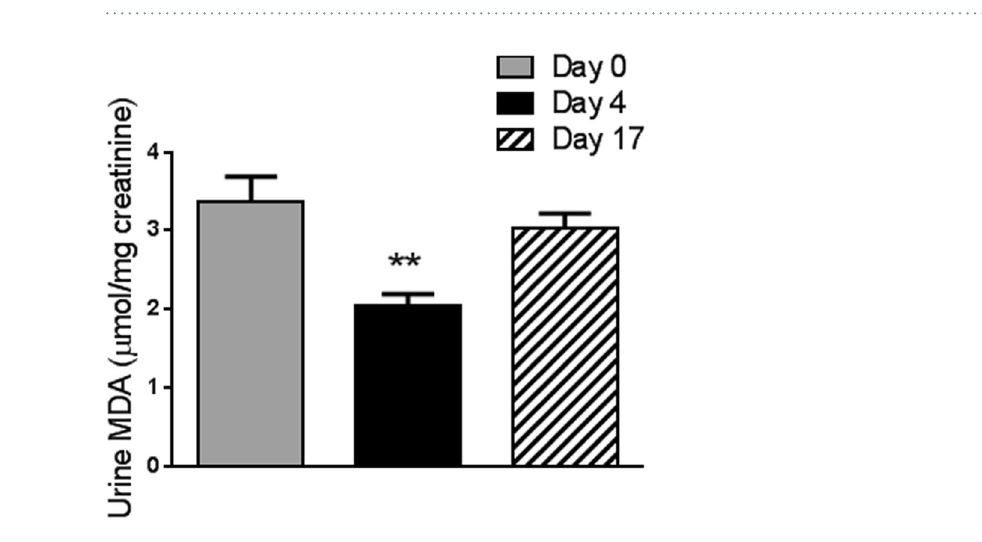
Figure 3. Effect of juice based diet on urinary malondialdehyde concentration. Data are mean ± SEM. One way repeat measures ANOVA was performed. The difference to baseline is indicated ** p <